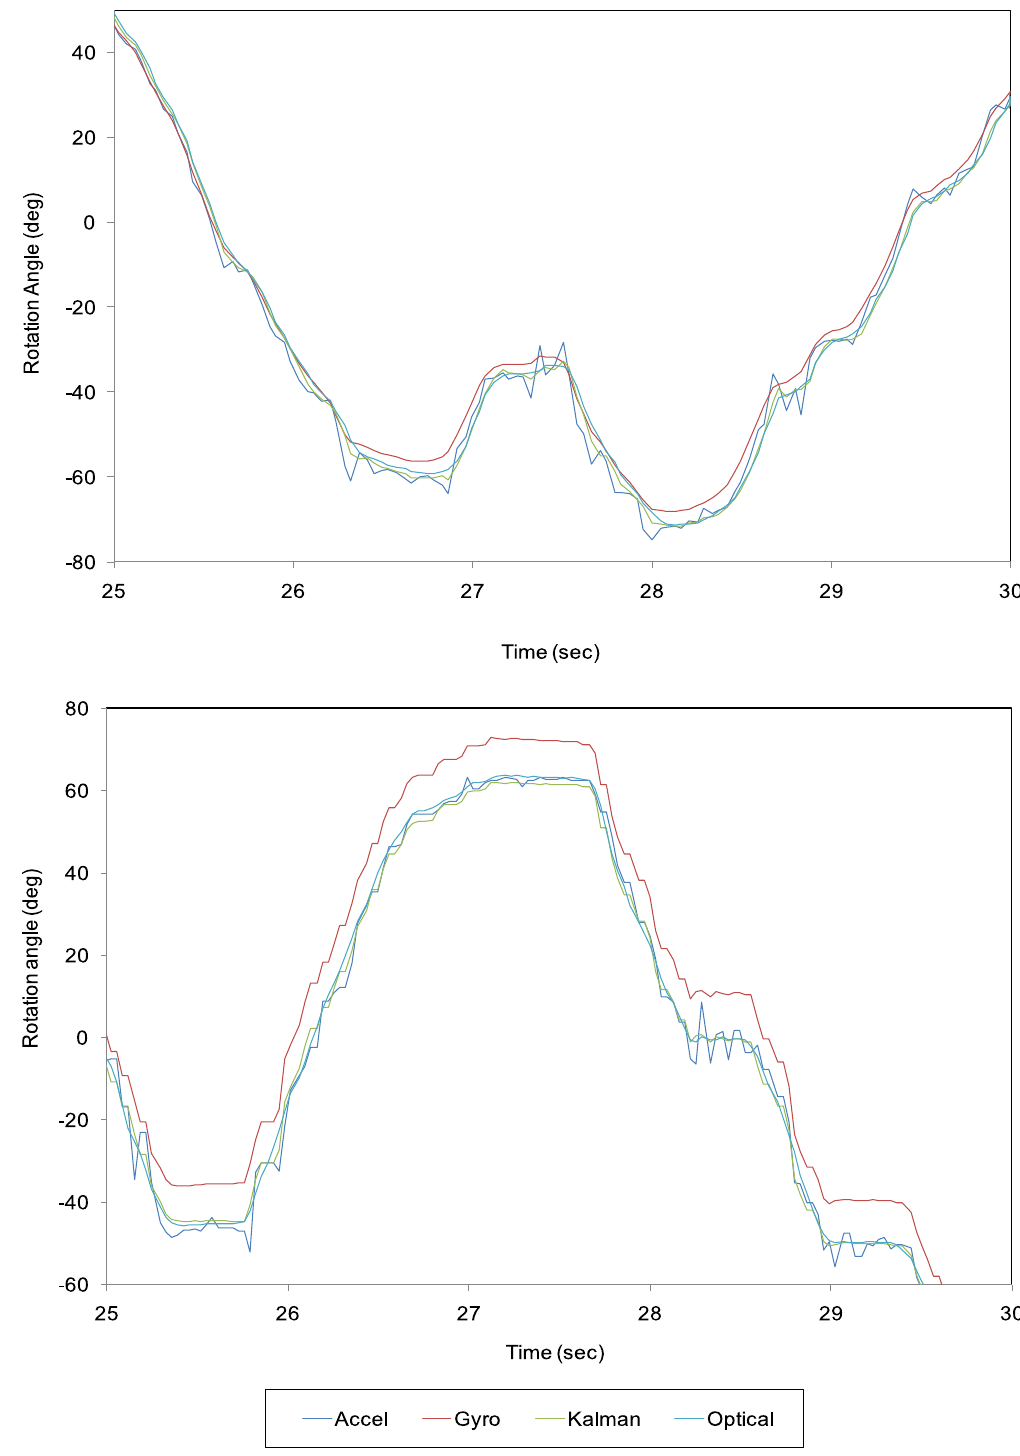
Fig 4. Results of the measuredand optical rotational angles from 25 to 30 seconds after beginning the experiments. A, wired connection; B, wirelessconnection.